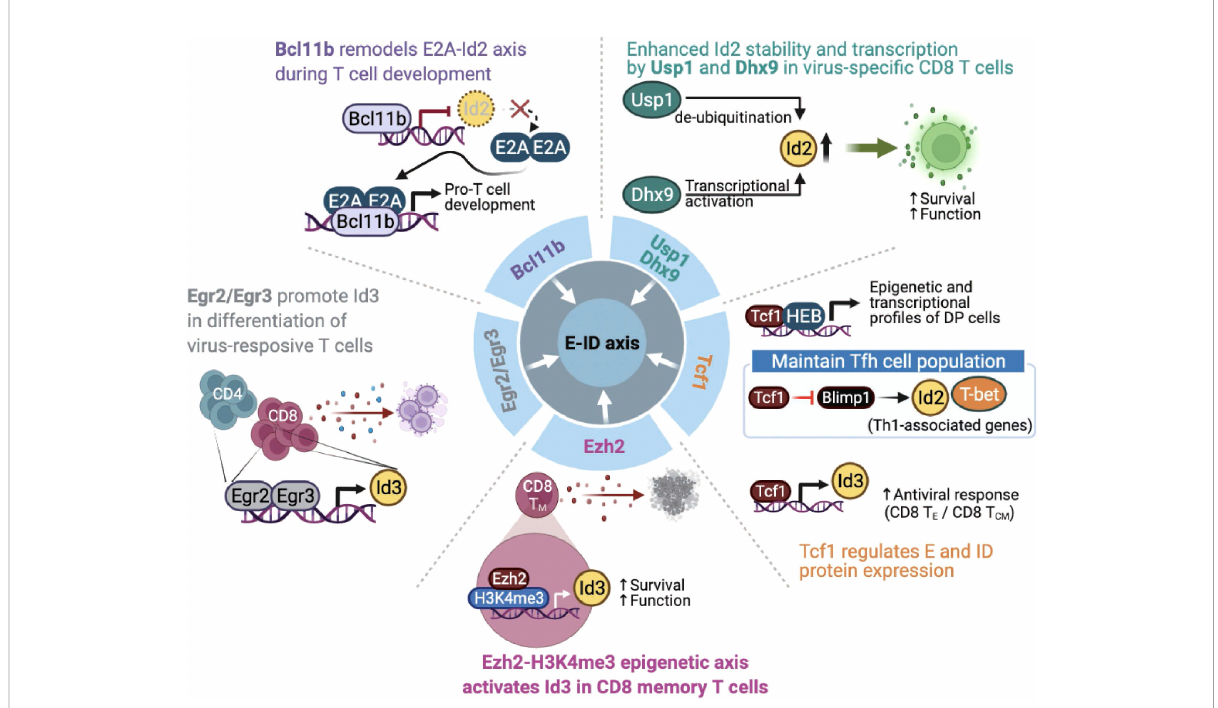
FIGURE 4 Endogenous factors in fl uence the E-ID axis in T cell fate and function. The roles and mode of action of endogenous proteins that control E and ID protein expression and affect T cell development, differentiation, and function (Bcl11b, B-cell lymphoma/leukemia 11B; Egr2/Egr3, early growth response 2/early growth response 3; Ezh2, Enhancer of zeste homolog 2; H3K4me3, histone H3 lysine 4 trimethylation; Tcf1, T cell factor 1; Blimp1, B-lymphocyte-induced maturation protein 1; Usp1, ubiquitin-speci fi c protease 1; Dhx9, DExH-Box Helicase 9; T E , Effector T cells; T CM, Central Memory T cells). This fi gure was created with